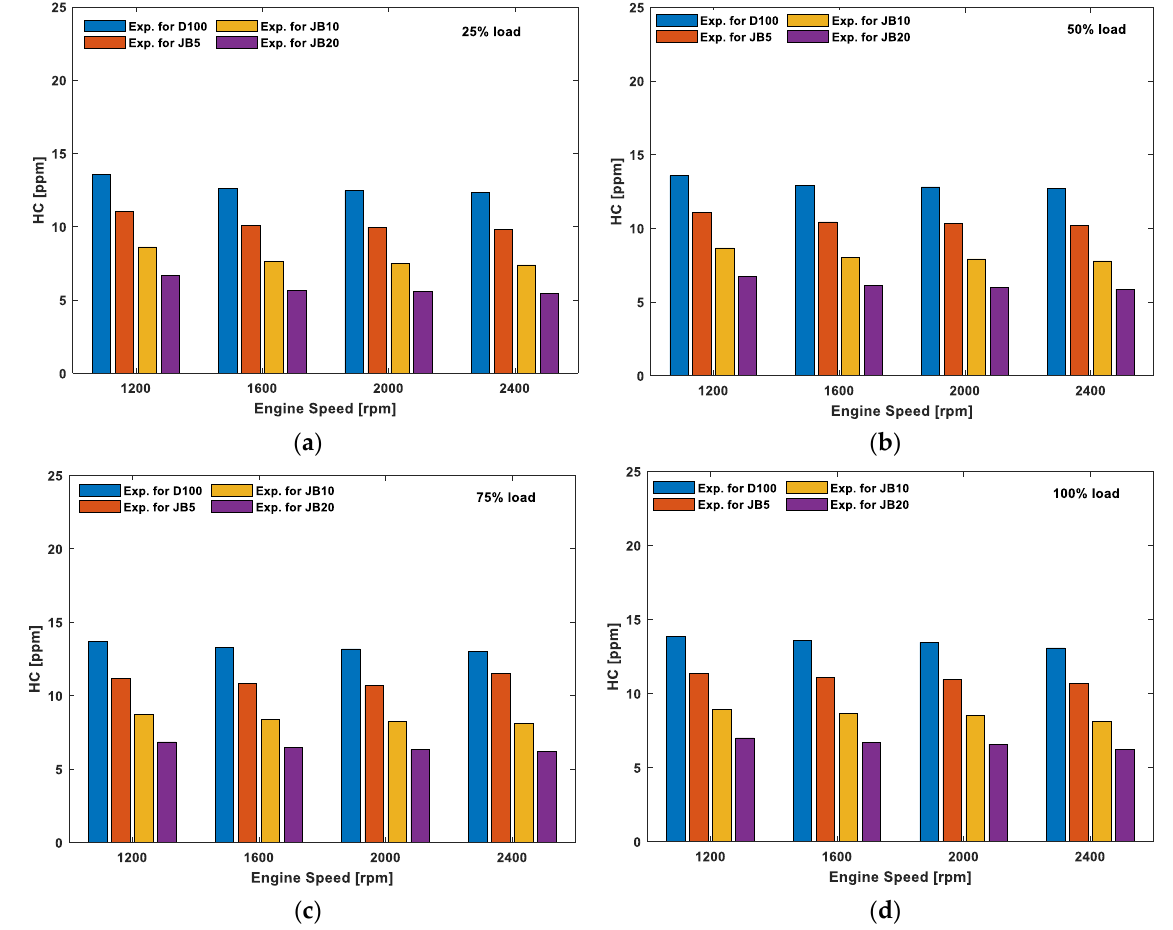
Figure 10. Variation in HC with engine speeds for D100, JB5, JB10, and JB20 at ( a ) 25%, ( b ) 50%, ( c ) 75%, and ( d ) 100% loading operation. Table 7. Finding of emissions for JB blends and diesel